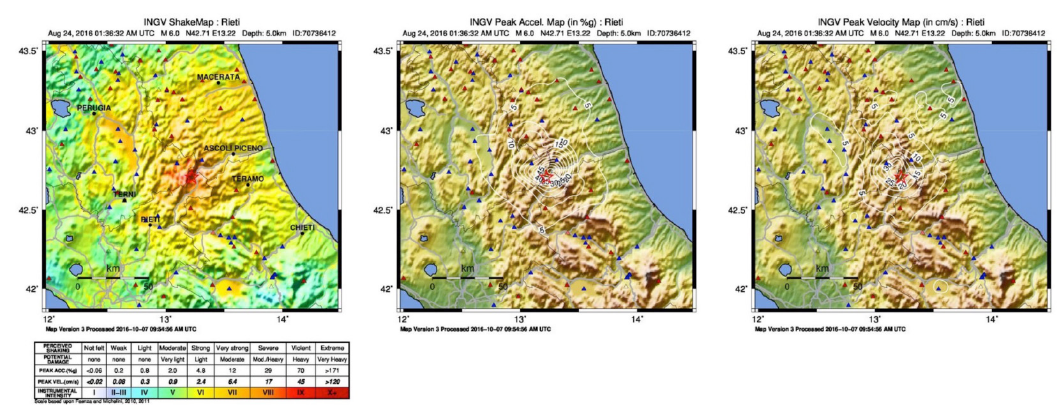
Figure 1. The Shakemaps of the main shock using automatic processing for the INGV PGM data and the PGM data provided by DPC. Left: MCS derived instrumental intensity; Center: PGA; Right: PGV.